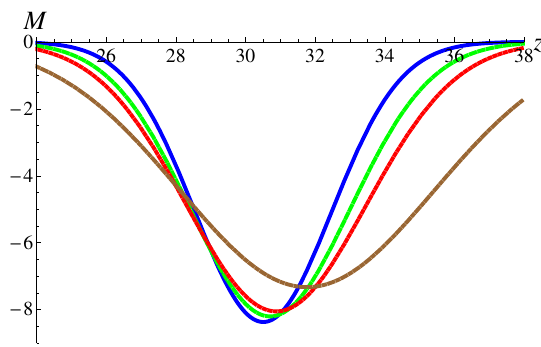
Figure 1 . The plot of M for various values of b = 2 : 8 (blue, solid), 3 : 3 (dashed green), 3 : 7 (dotted red), and 5 : 3 (dotdashed, brown) in the case a = n = 30, m 0 = 1, q 0 = 3, and B 0 = 0 :